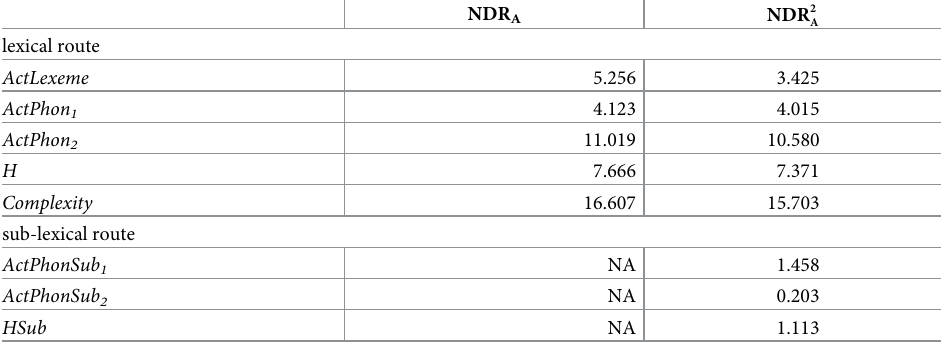
Table 6. Results of a linear model predicting observed reaction times from model components. Listed values are component t